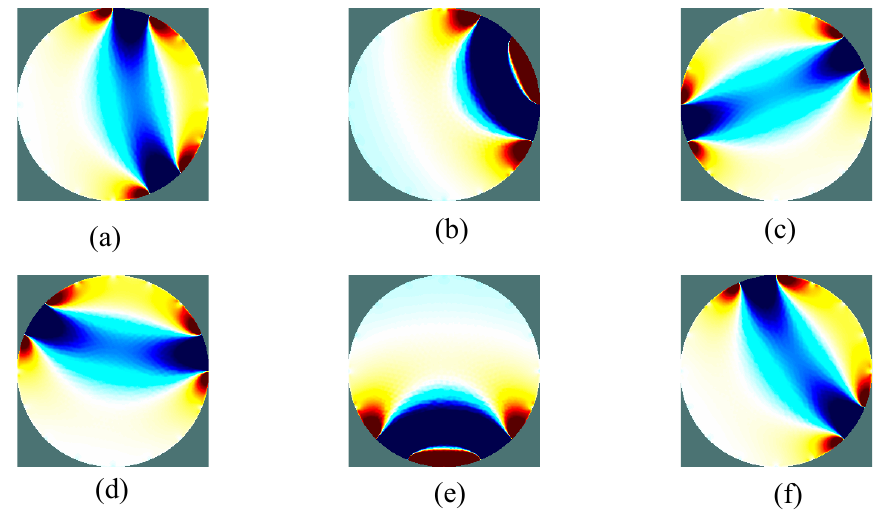
Figure 5. The Sensitivity field of Electrically Conductive Silicone. ( a ) is the sensitivity field distribution of silicone rubber between electrode 1 and electrode 7; ( b ) is the sensitivity field distribution of silicone rubber between electrode 2 and electrode 4; ( c ) is the sensitivity field distribution of silicone rubber between electrode 3 and electrode 11; ( d ) is the sensitivity field distribution of silicone rubber between electrode 4 and electrode 14; ( e ) is the sensitivity field distribution of silicone rubber between electrode 6 and electrode 9; ( f ) is the sensitivity field distribution of silicone rubber between electrode 5 and electrode 15.